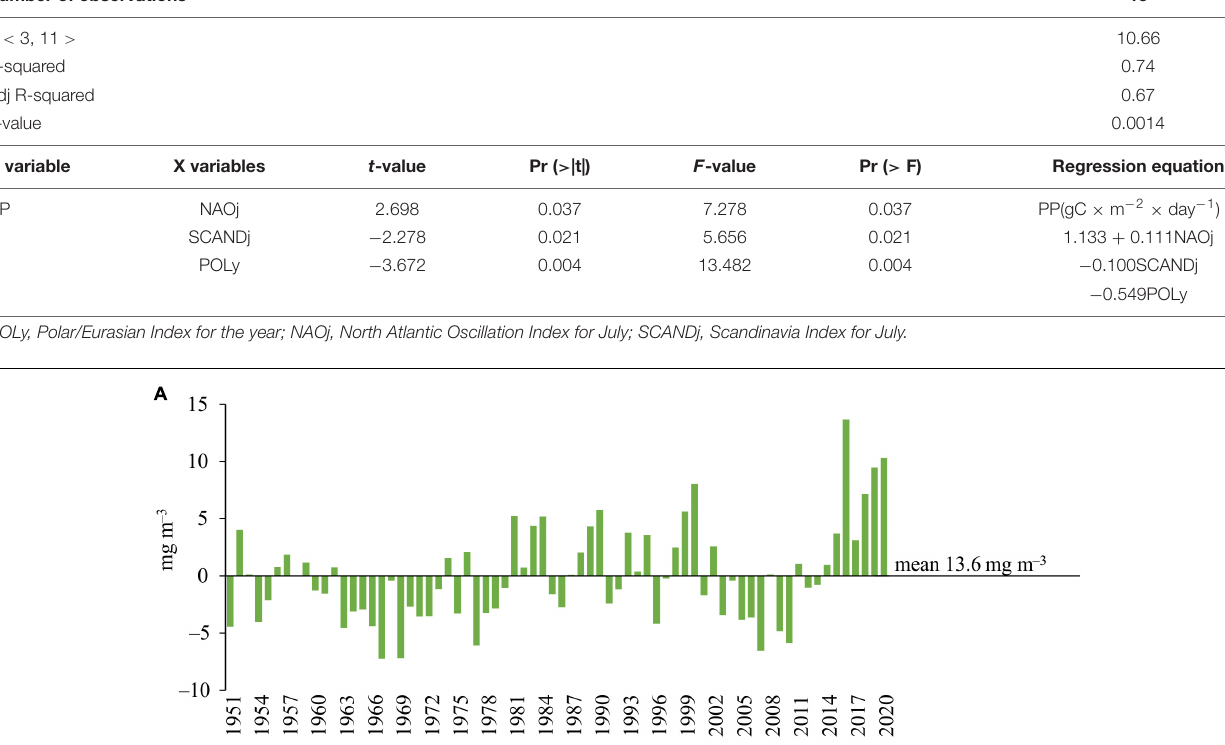
TABLE 4 | Results of stepwise multiple regression analysis between plankton primary production (PP) (variable Y, predictand) and values of climatic indices (variables X, predictors). Number of observations